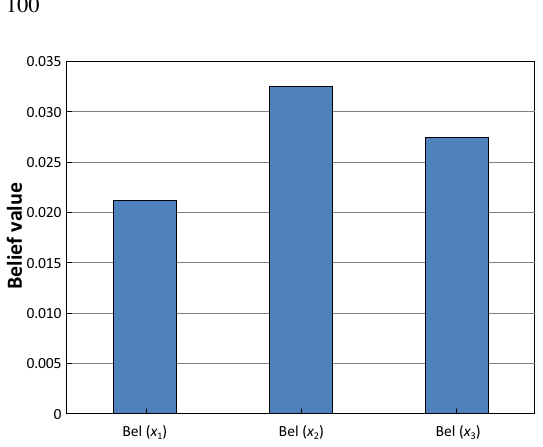
Fig. 2 Interpretation of belief values for experiment.